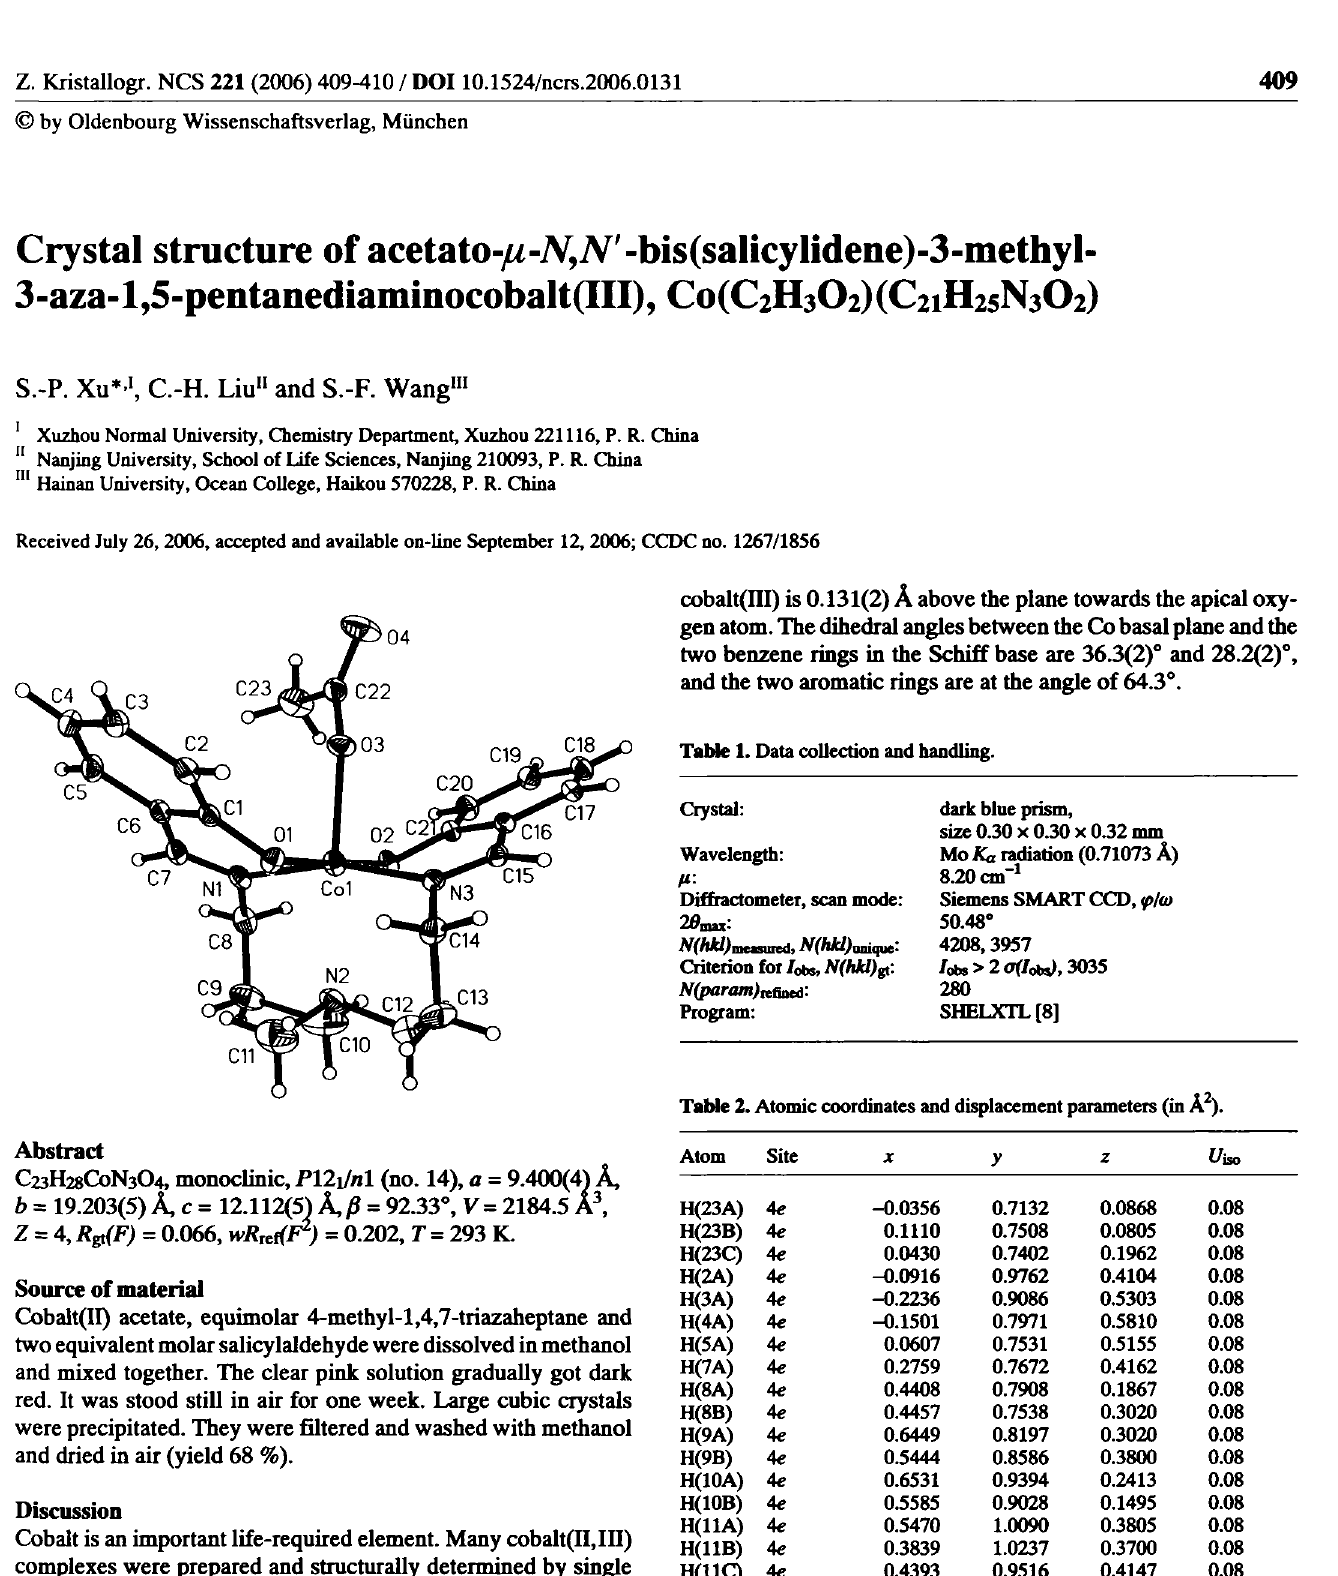
Table 2. Atomic coordinates and displacement parameters (in A 2